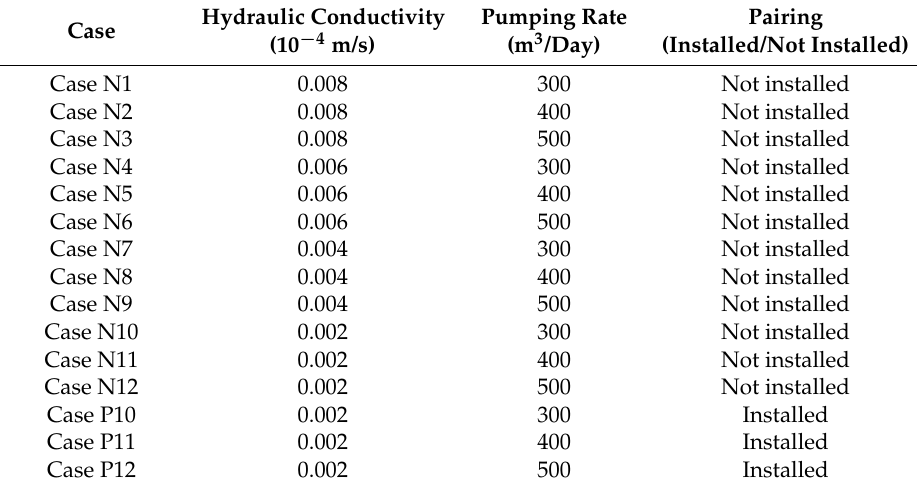
Table 7. Simulation condition of all